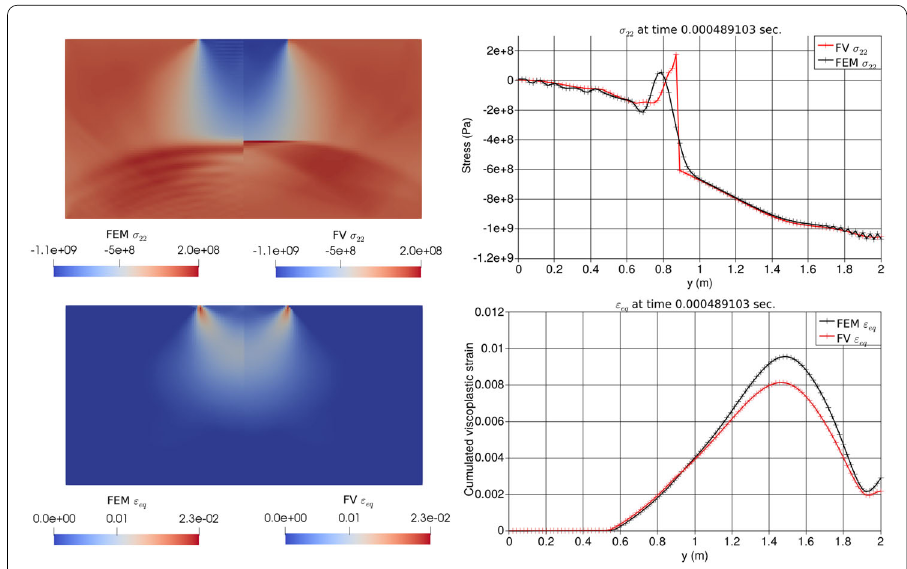
Fig. 14 Normal stress σ 22 and cumulated viscoplastic strains ε eq at time 4 . 89 × 10 − 4 s, computed on a 100 × 100 refined cartesian mesh with finite elements (left-half domain) and finite volumes (right-half domain). Superposed plots are made along the symmetry